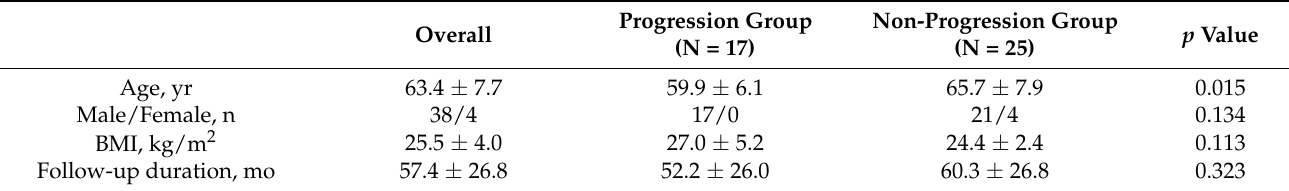
Table 1. Patient characteristics according to osteoarthritis progression.